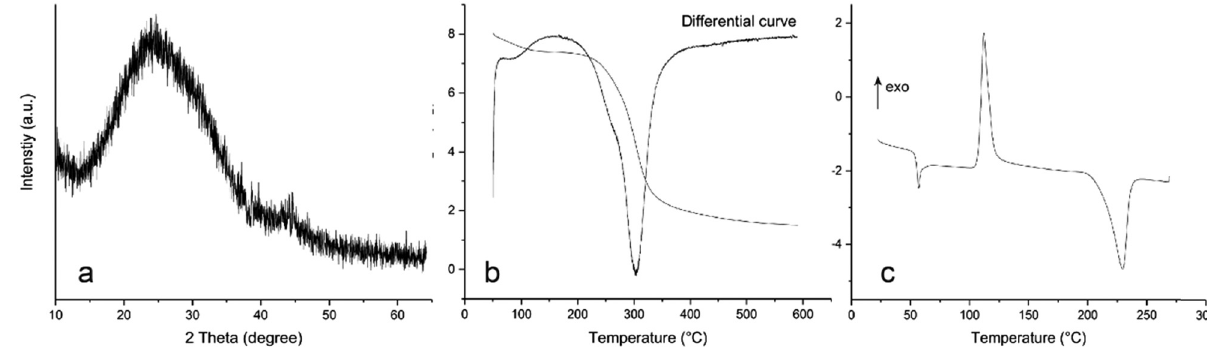
Figure 3: XRD, TGA and DSC spectrogram of the sample: ( a ) XRD curve, ( b ) TGA curve and ( c ) DSC